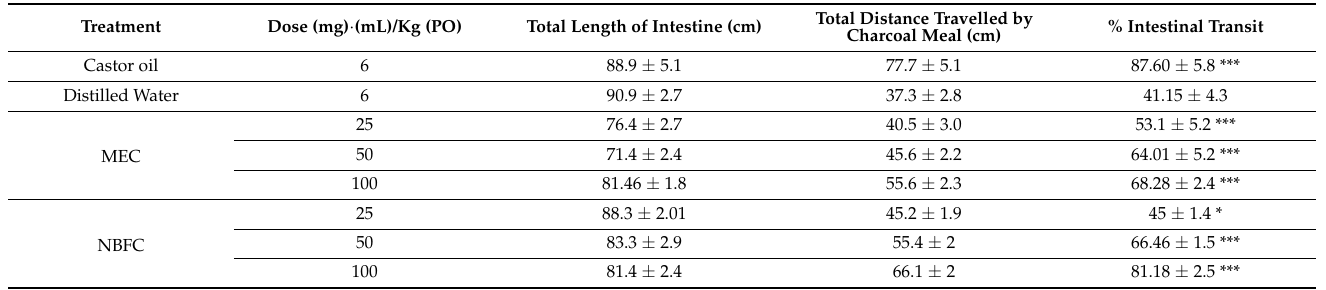
Table 9. Percent intestinal transit of MEC and NBFC in pigeons.